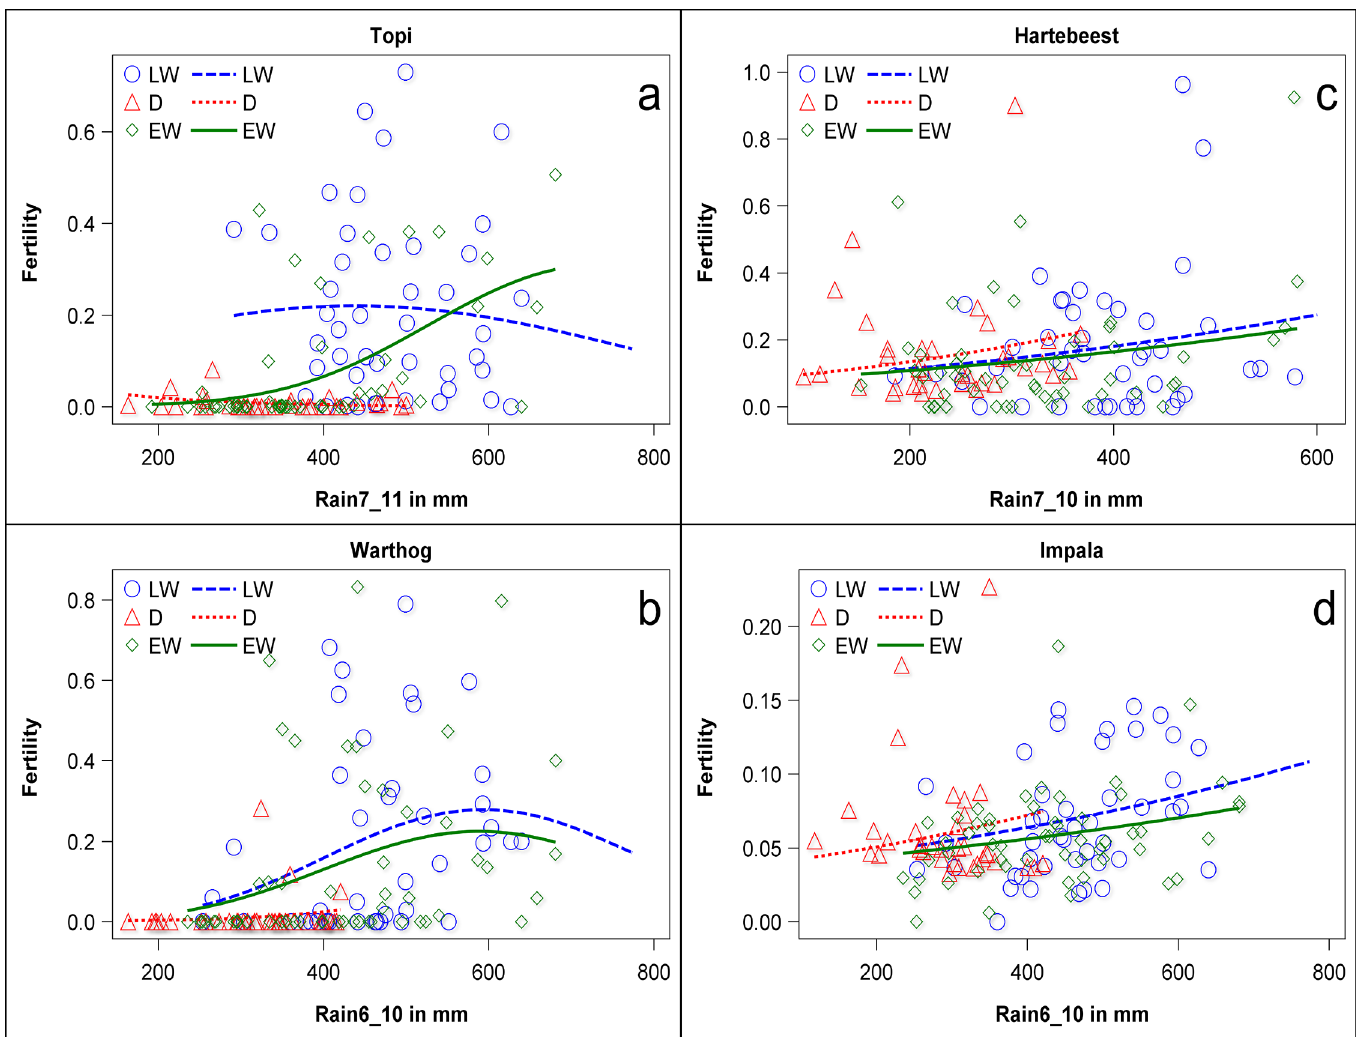
Fig 1. Relationships between apparent fecundity and the best-supported rainfall block spanning conception months for each ungulate species for the early wet (Nov-Dec), late wet (Jan-June) and dry (Jul-Oct) seasons of conceptions for a) topi, b) warthog, c) hartebeest and d)